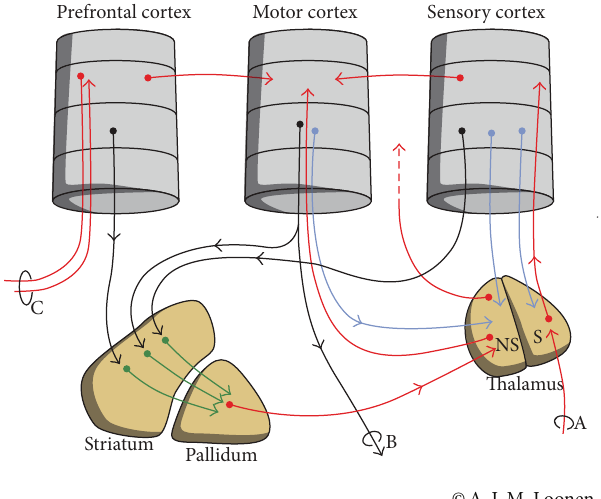
Figure 2: Simplified representation of the corticostriatal processing unit in which cortical information leading to a movement is processed in an intracortical and (parallel) extrapyramidal fashion; (A) sensory input, (B) projections to brainstem and spinal cord, and (C) projection to and from ipsilateral and contralateral cortical areas. NS = nonspecific part; S = specific